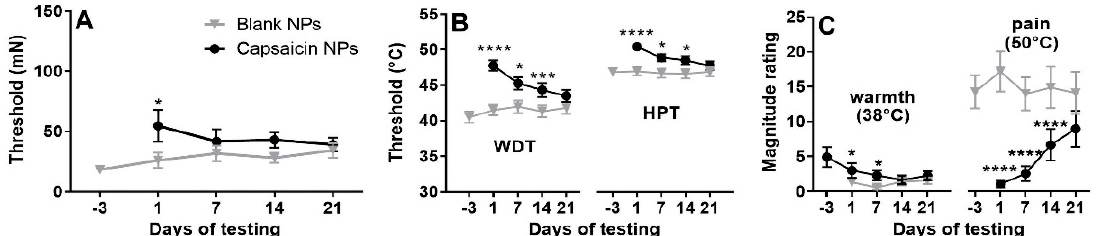
Figure 5. Mechanical pain thresholds, and thresholds and magnitude ratings of warmth and heat pain. ( A ) Thresholds for mechanically evoked pain (MPT) obtained at sites of blank and capsaicin NPs obtained 4 days before and on each designated day after removal of the NPs. ( B ) Detection thresholds for warmth (WDT) and heat pain (HPT, same format as in A). ( C ) Magnitude ratings of warmth and heat pain produced by 38 and 50 °C, respectively. n = 21, mixed effect model 2 within subject treatments (capsaicin vs. placebo treatment) × 4 repeated timepoints (0, 7, 14, 21 days) with Bonferroni correction. Means with SEMs for capsaicin and blank NPs are black and gray, respectively. * p < 0.05, *** p < 0.001 and **** p < 0.0001 for blank vs. NP comparison.